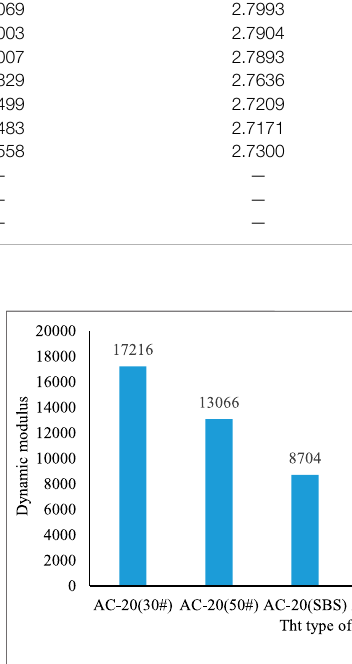
FIGURE 3 | Dynamic modulus test results of the middle and lower course of asphalt mixture in each